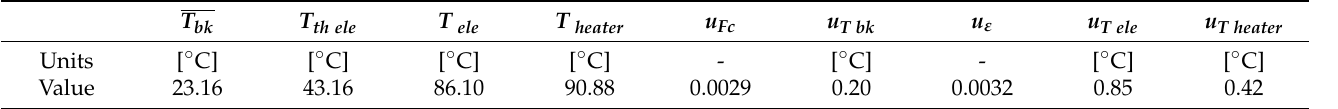
Table 2. Corrected temperatures and measured uncertainties.